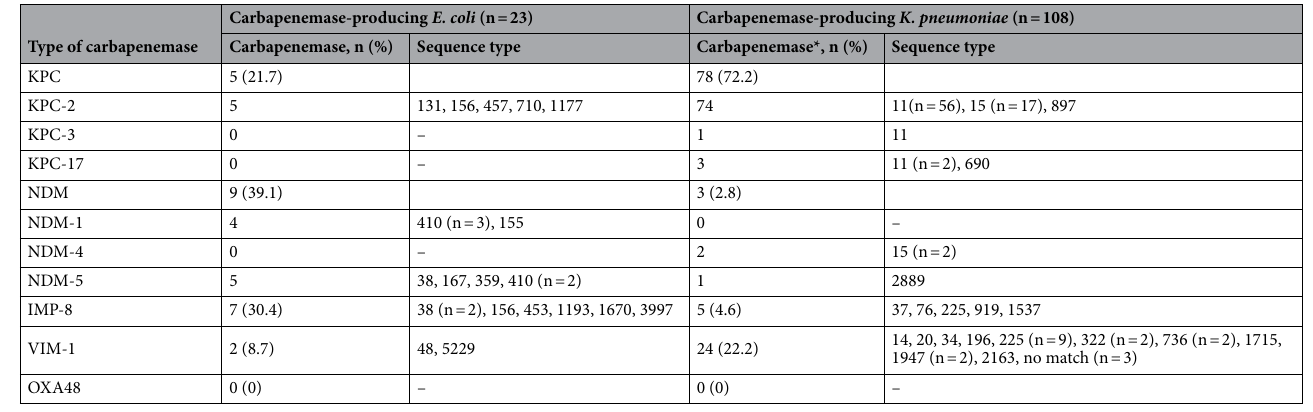
Table 1. The distribution of carbapenemases and sequence types of carbapenemase-producing E. coli and K. pneumoniae, 2016–2018. *Two carbapenemase-producing K. pneumoniae isolates were positive for dual carbapenemase: one positive for IMP-8 and VIM-1; the other positive for KPC-2 and